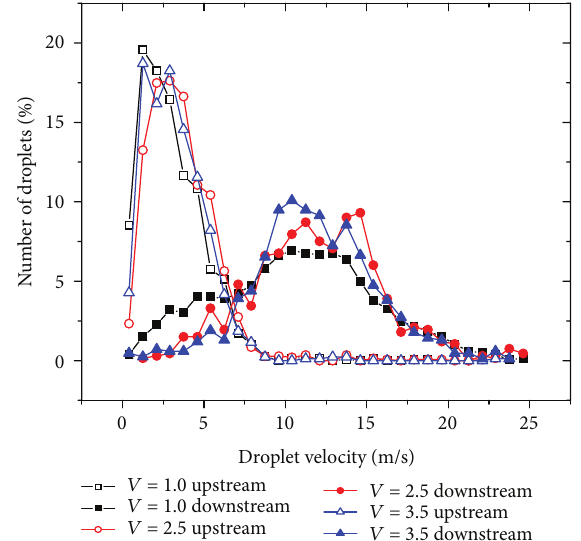
Figure 7: Velocity distributions of droplets for various reflood rates when 𝑄 = 1.5 kW/m. Table 2: Main test conditions of the blockage tests. 𝑉 𝑟 (cm/s)/Test conditions